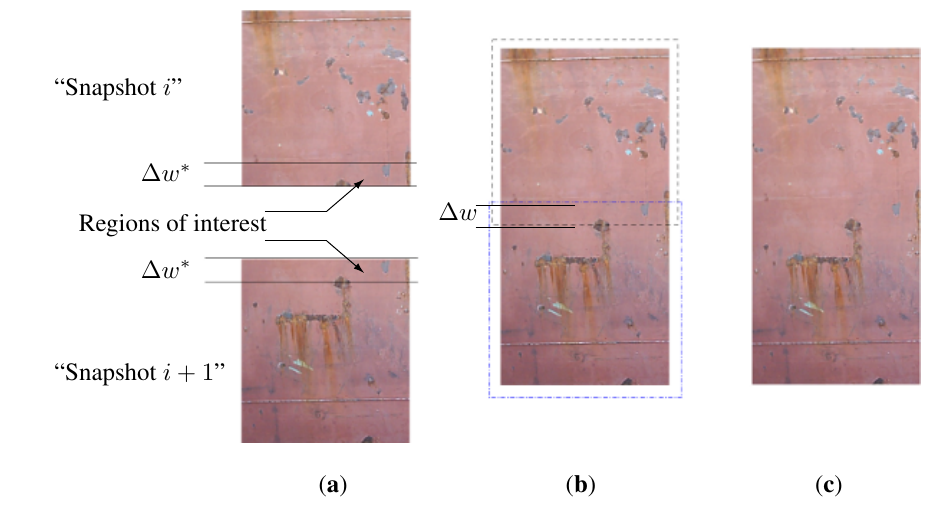
Consecutive image acquisition process when covering the vertical inspection